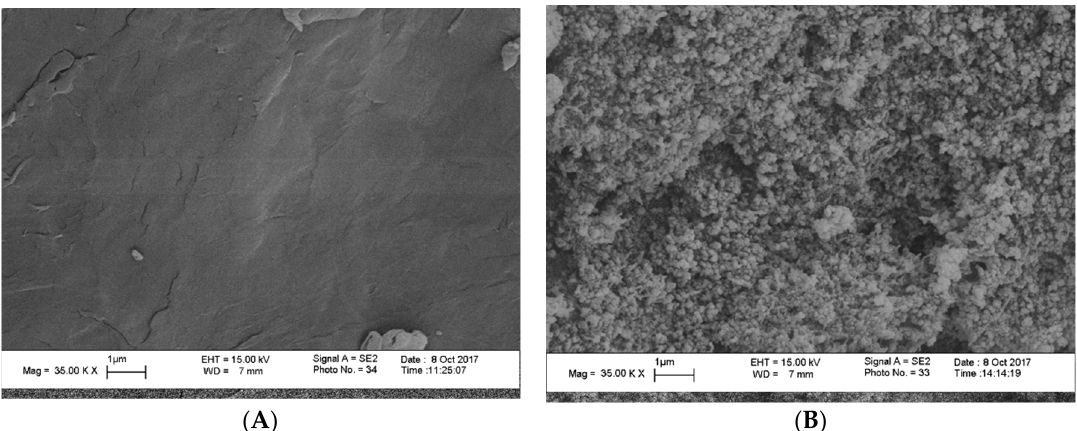
Figure 3. FESEM images of chitosan ( A ), and chitosan-MgO 10 wt% ( B ).